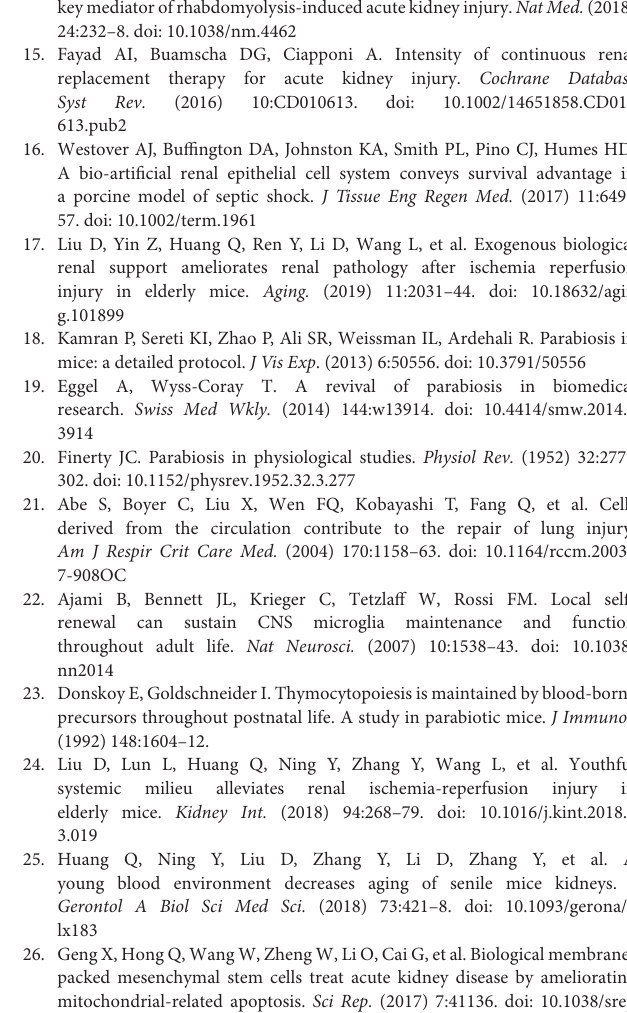
Supplementary Figure 3 | Principal component analysis. Supplementary Figure 4 | Differentially expressed protein statistics. Supplementary Figure 5 | Domain enrichment analysis of proteins in kidney tissue. Supplementary Figure 6 | Domain enrichment analysis of proteins in serum. Supplementary Figure 7 | CK and myoglobin (MYO) expression levels. Supplementary Table 1 | Different proteins in the P_RM_R group vs. the RM group at 48h. RM, rhabdomyolysis; P_RM_R, the mouse in the parabiosis model administered